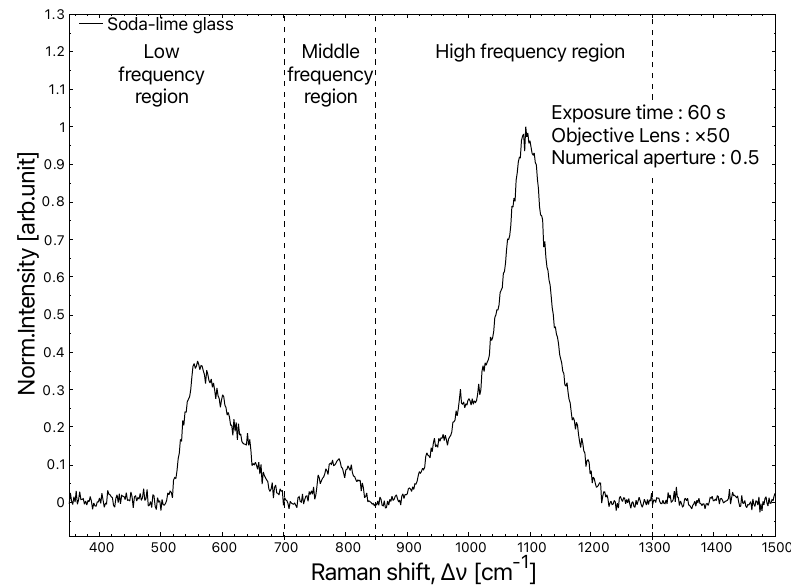
Figure 3. Typical Raman spectrum of soda–lime